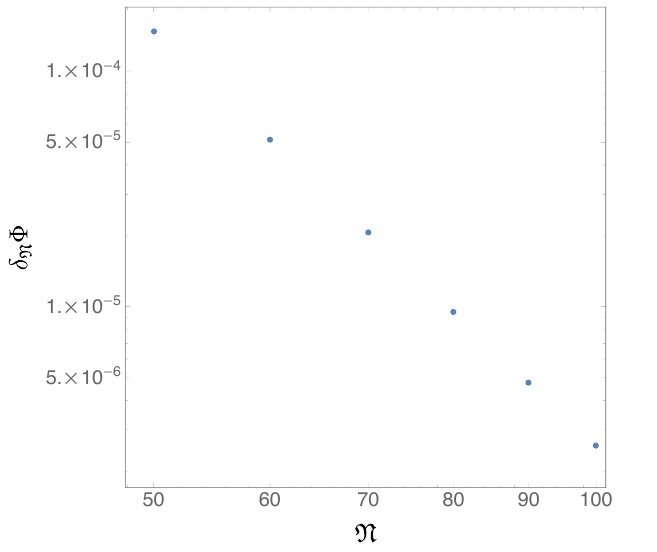
Figure 10 . (cid:14) N (cid:8) as a function of N computed for (cid:12)xed (cid:28) = 0 : 7293. Convergence is now consistent with (cid:14) N (cid:8) / N (cid:0) 5 : 85 . conformal boundary (see eq. (4.2)). In (cid:12)gure 9 we show a logarithmic plot of max